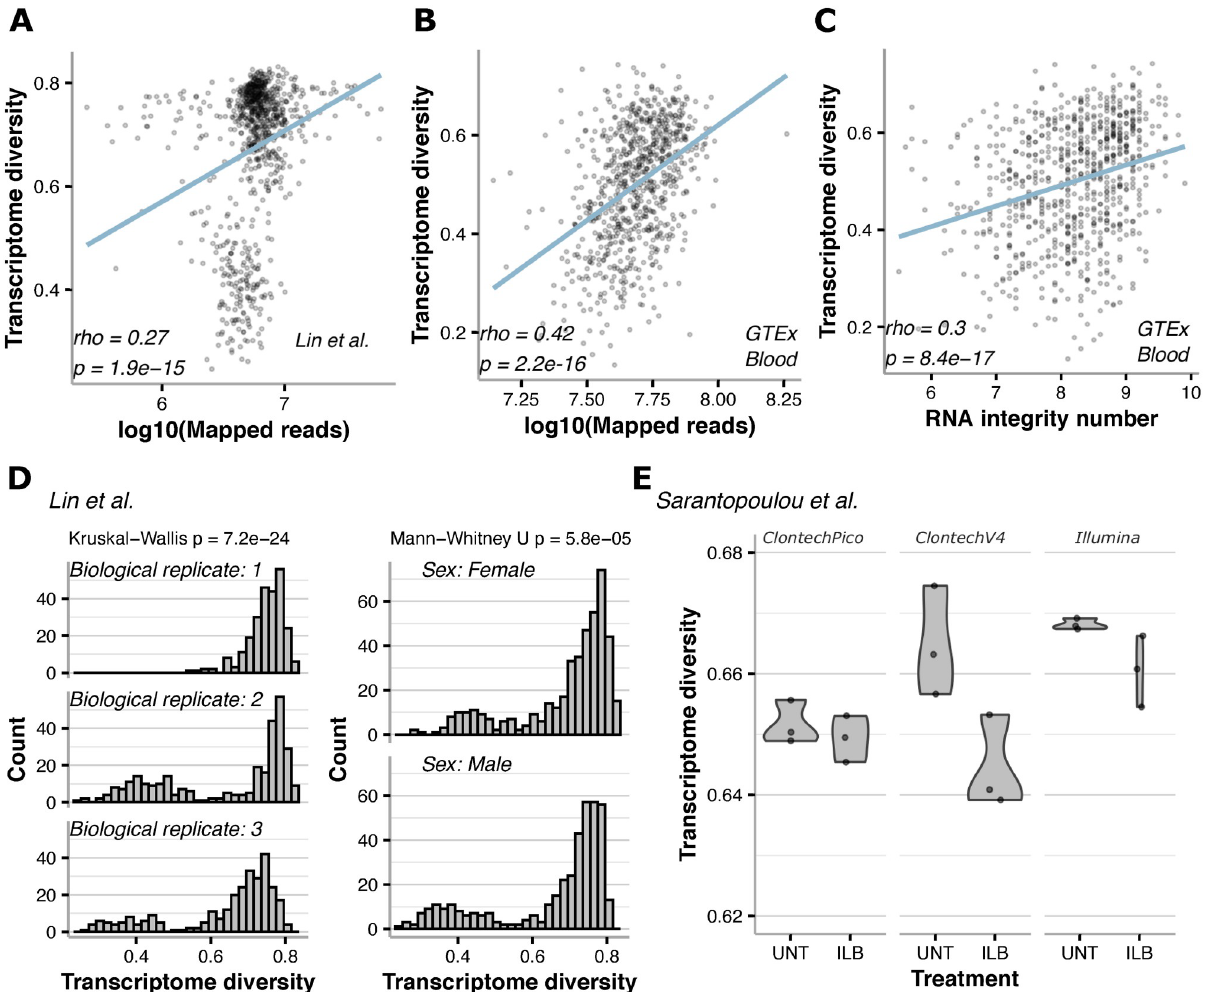
Fig 6. Other technical and biological factors are associated with transcriptome diversity. A,B transcriptome diversity was consistently associated with RNA-seq sequencing depth, shown for D . melanogaster [16] and GTEx blood. C RNA integrity also exhibited significant correlations with transcriptome diversity as shown here for GTEx blood. D RNA-seq data from D . melanogaster [16] show that transcriptome diversity can differ across biological replicates (left) as well as sex (right). E Different sequencing library preparations and perturbations result in varying transcriptome diversity distributions as shown by these violin plots. UNT is untreated mouse liver samples and ILB is Interleukin 1 beta treatment.